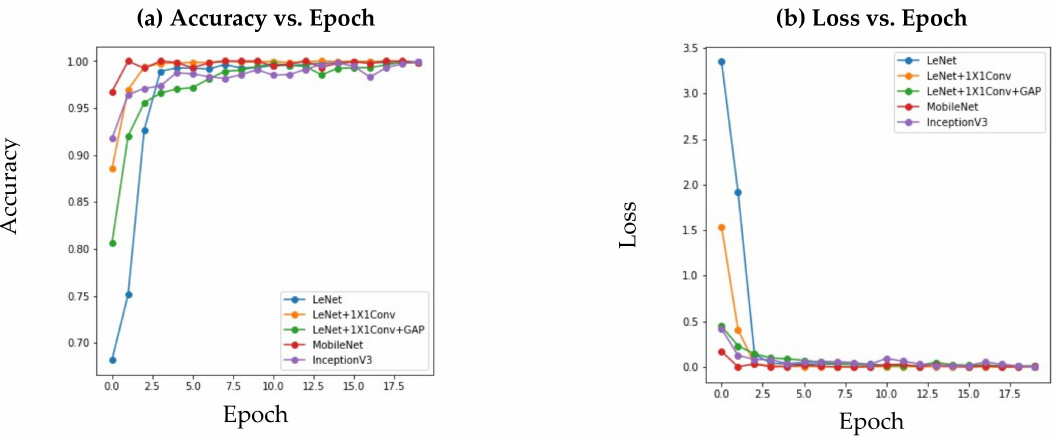
Figure 12. CNN Algorithm Comparison for Accuracy and Loss with Best-Fold